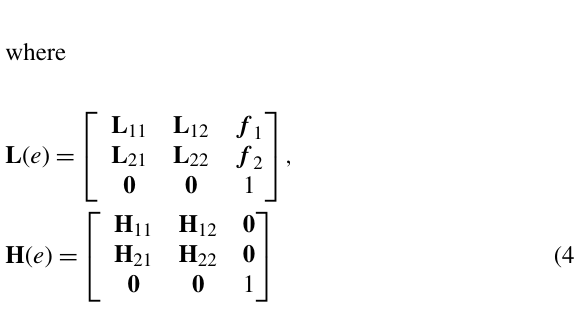
According to Eqs. (13) and (14) the state variable z 1 rep- resents six-component displacement vectors for V ( a ) and V ( b ), respectively, and the state variable z 2 represents six- component internal forces vectors S ( a ) and S ( b ), at loca- tions ( x = 0) and ( x = L )